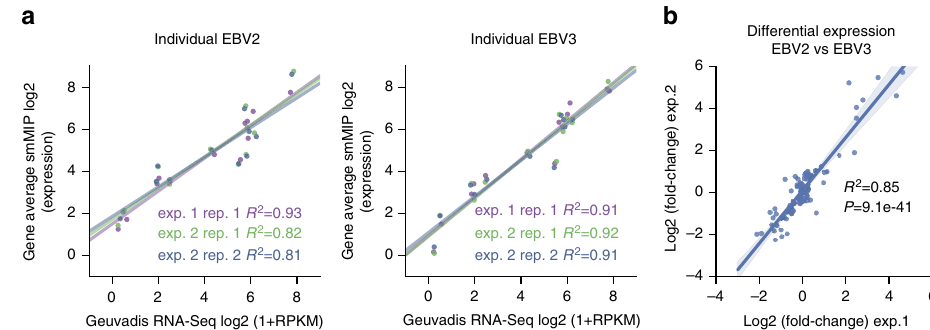
Figure 2 | Validation of cDNA-smMIPs using on lymphoblastoid cell lines. ( a ) Quantification of relative gene expresssion on endogeneous transcripts of EBV-transformed lymphoblastoid cell lines compared with average gene expression from RNA-Seq data of 660 samples in the Geuvadis project 15 for the same cell type. Two experiments were performed (exp. 1 and exp. 2); in the second experiment, two technical replicates were created by two independent experimenters (designated by Rep. 1 and Rep. 2, see Supplementary Table 2). cDNA for experiments 1 and 2 was generated independently from the same RNA for EBV2 and EBV3. ( b ) Concordance of differential expression between sample EBV2 and EBV3 for individual smMIPs ( N ¼